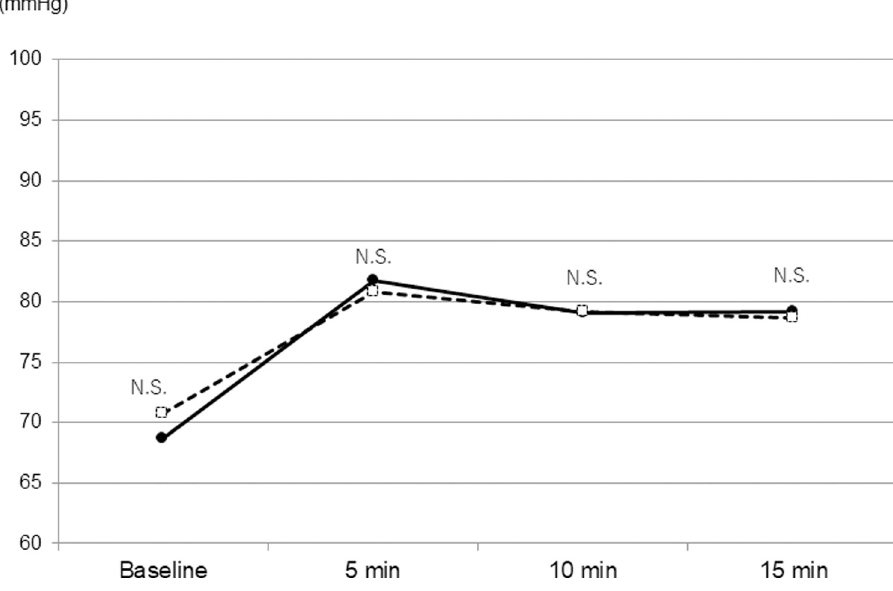
Fig 2. Time course of diastolic blood pressure in the DM group (solid line) and non-DM group (dashed line). P- values are the results of unpaired t -test.